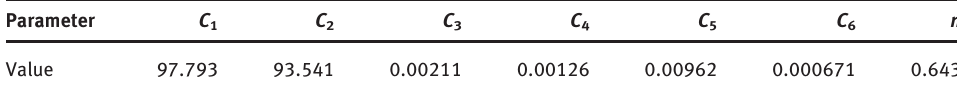
Table 4: Parameters for the modified ZA model.